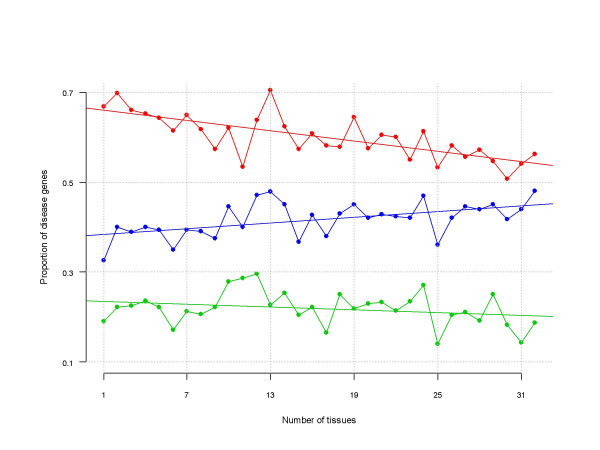
Disease association and tissue specificity. Relationship between tissue specificity (x-axis) and proportion of disease-associated genes (y-axis) computed using all genes (blue pattern), and separate for non-interacting (green pattern) and interacting genes (red pattern).